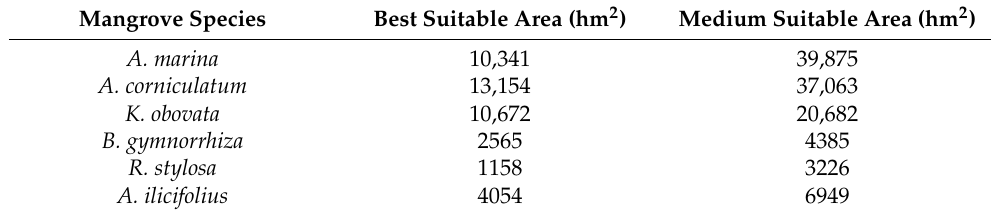
Table 4. Suitable mangrove areas for species of interest.